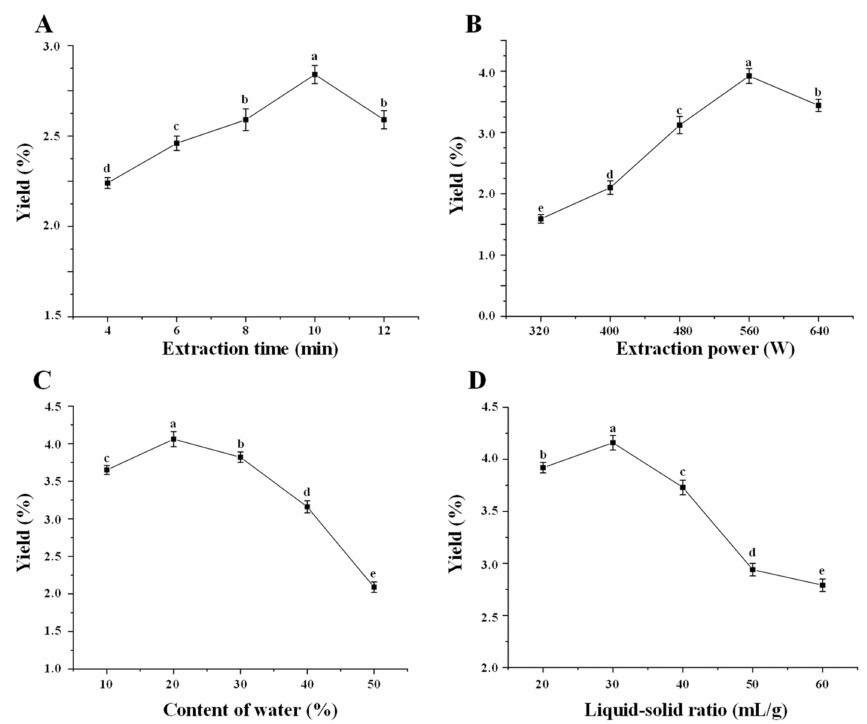
Figure 1. Effects of extraction time ( A ), extraction power ( B ), content of water ( C ), and liquid–solid ratio ( D ) on the yields of polysaccharides extracted from sweet tea leaves by microwave-assisted deep eutectic solvent extraction. Significant differences ( p < 0.05) between samples are shown by data bearing different